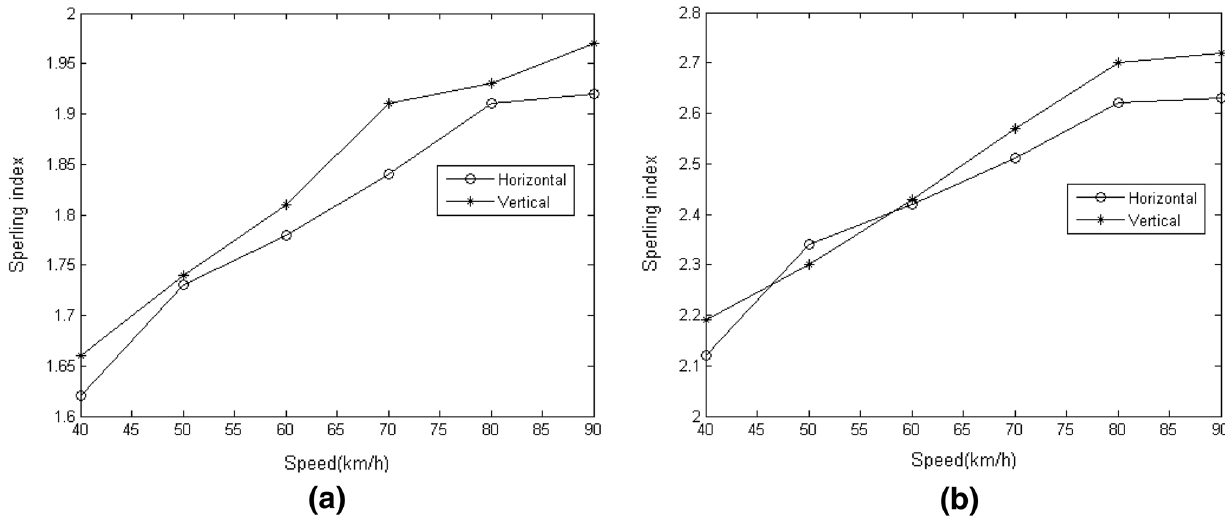
Fig. 11 Sperling indexes of vehicle, a track spectrum coefficient of 0.5, b track spectrum coefficient of 1 Fig. 12 Force analysis model of the vehicle during